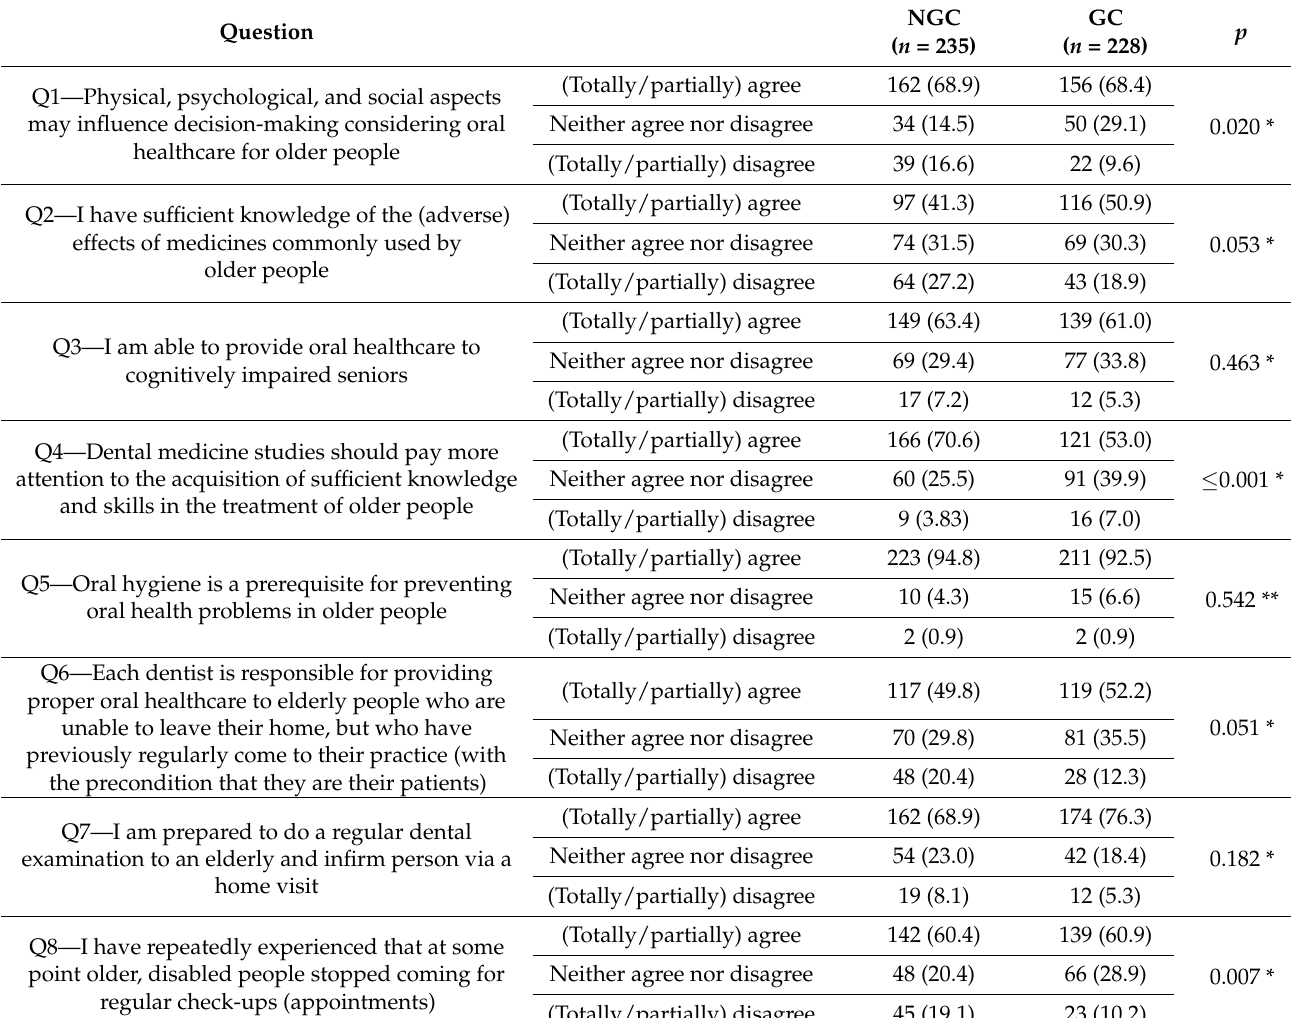
Table 3. Respondents’ opinions on knowledge, attitudes, and barriers in providing oral care to older people depending on whether or not they attended a geriatric dentistry course during their